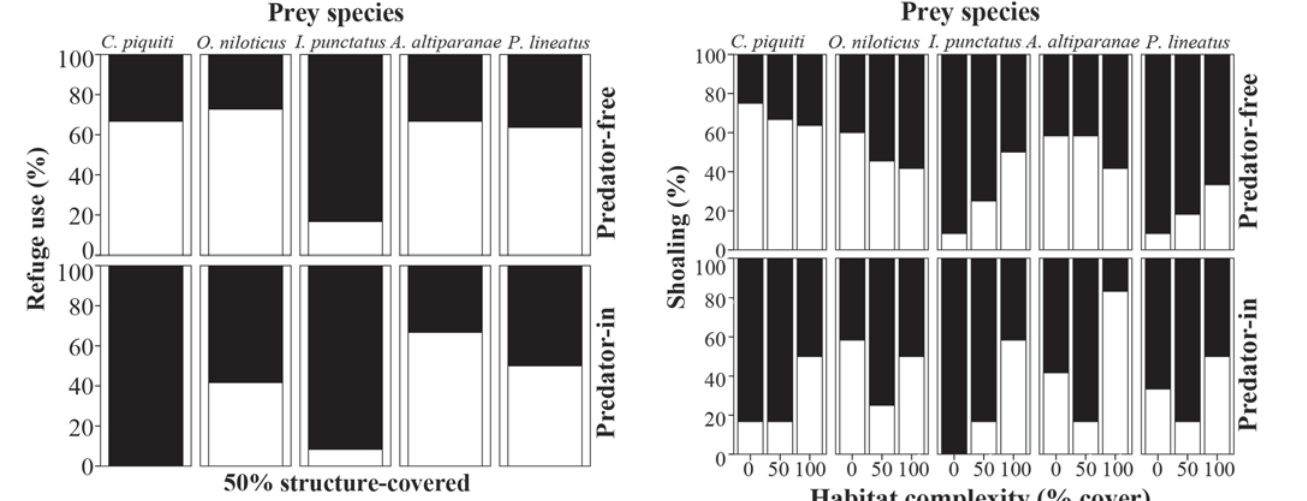
Fig. 6. Shoaling (%) of prey species in response to predator presence ( P. corruscans ) and levels of habitat complexity. Black square = shoaling, white square = dispersed. Top panel = predator-free; bottom panel = predator-in